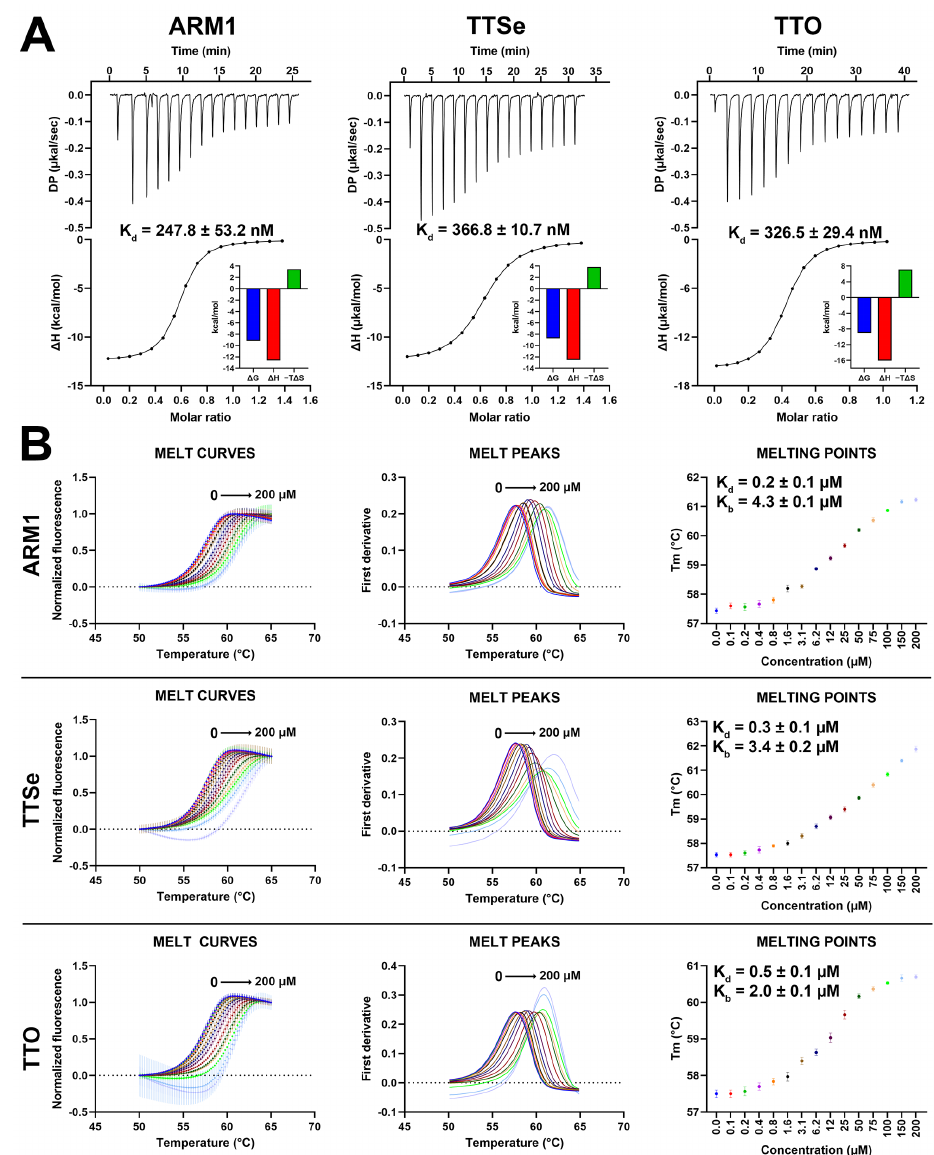
Figure 6. Binding parameters of chalcogen-containing inhibitors with LTA 4 H. ( A ) Isothermal calori- metric analysis (ITC) of 100 µ M LTA 4 H with 15 µ M ARM1, 15 µ M TTSe and 20 µ M TTO in 25 mM Tris pH 7.8 with 3% DMSO at 25 ◦ C. The dissociation constants (K d ) were determined based on the titration curves. Data are presented as mean ± SEM with n = 4. ( B ) The thermal stability of LTA 4 H by selective inhibitors assessed by differential scanning fluorimetry. Different colors represent different inhibitor concentrations. The dissociation (K d ) and stability (K b ) constants were determined based on the dose − response